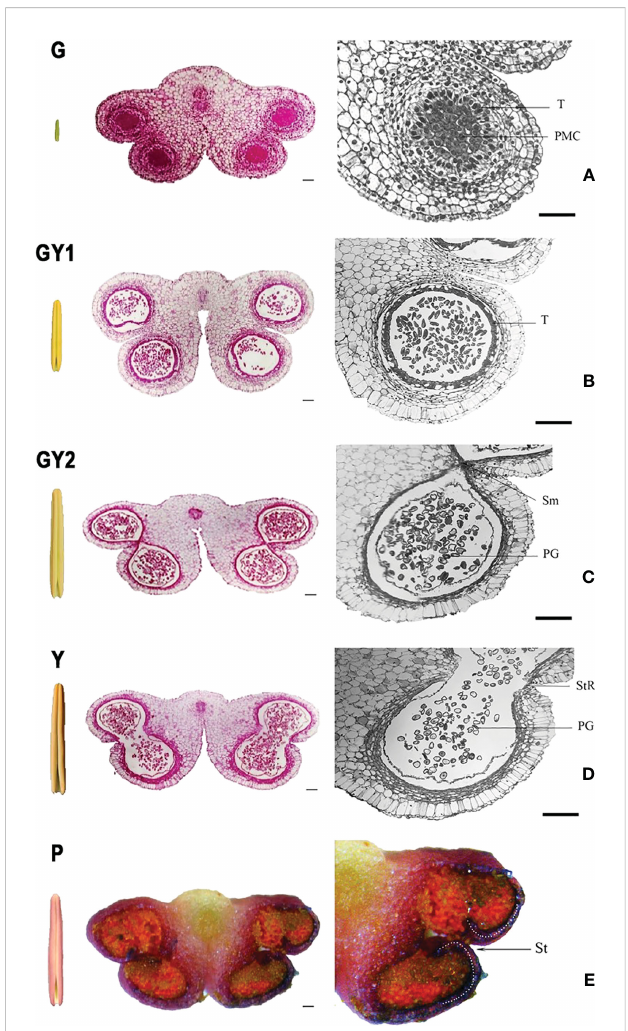
FIGURE 2 Anatomical structure of the anther at fi ve developmental stages in Lilium Oriental Hybrid ‘ Siberia ’ . Each stage includes a global external view of the anther, a transverse section of the complete anther with four locules, and a section of a single anther locule. (A) green stage (G) , (B) green-to-yellow 1 stage (GY1), (C) green-to-yellow 2 stage (GY2), (D) yellow stage (Y), and (E) purple stage (P). Bar = 100 m